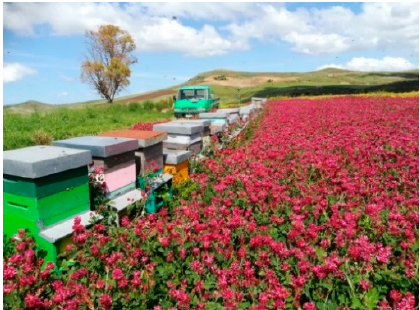
Figure4. Figure 4. Hives in a French honeysuckle plot arranged along a straight line with an East–West orientation.